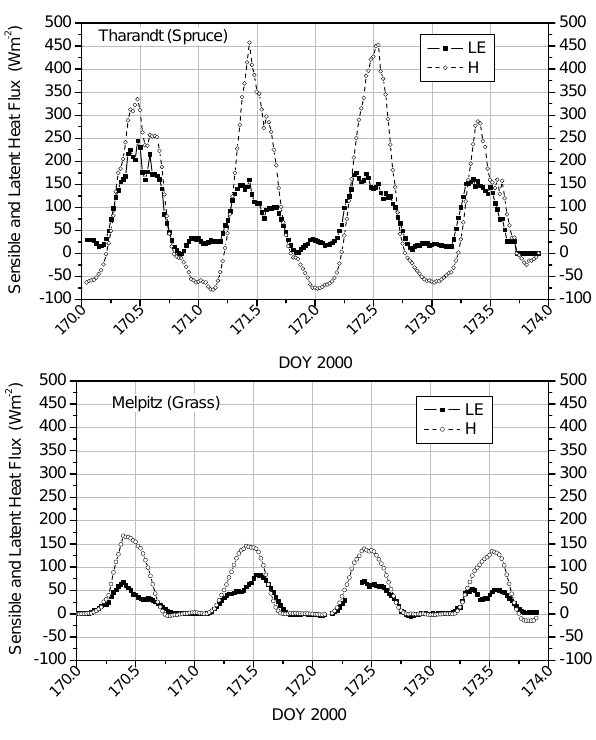
Fig. 7. Three-hours running mean of sensible (H) and latent heat flux (LE) at the Anchor Station Tharandt (spruce, minor water lim- itation, panel above) and at the Melpitz experimental site (short grass, strong water limitation, panel below) during the investigation period 18 to 21 June 2000. (Note: grass measurements are based on raw eddy covariance without spectral correction.)